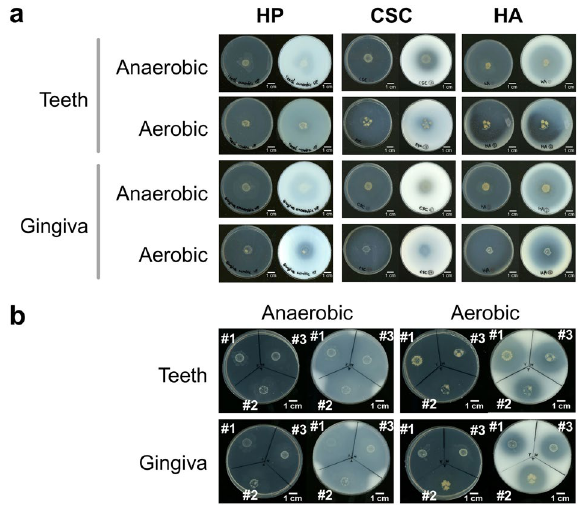
Figure 3. GAG degradation by human oral microbiota. ( a ) Microbial community from teeth or gingiva of donor #1 was grown anaerobically or aerobically on the center of the halo-forming minimal medium plate containing HP (left), CSC (middle), or HA (right). ( b ) Microbial communities from teeth or gingiva of donors #1 to #3 were grown anaerobically or aerobically on the center of the halo-forming minimal medium plate containing HA. After full growth on the medium plate (left), acetic acid was spread onto the plate for halo formation (right). Bar, 1 cm. The oral microbiota from teeth or gingiva of healthy donors degraded HA under both anaerobic and aerobic conditions.